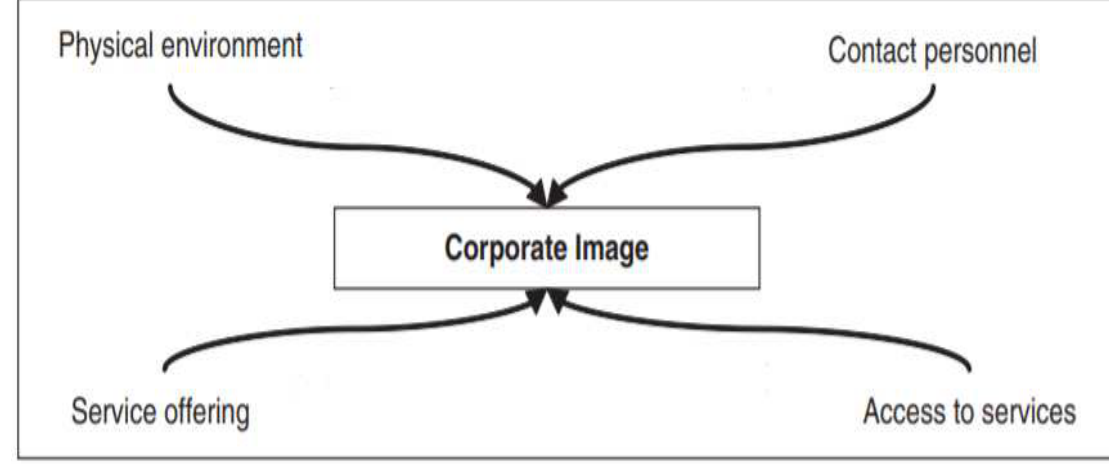
Fig. 2. The model by Tubillejas, Cuadrado, and Frasquet (2011) Source: Tubillejas, Cuadrado, and Frasquet